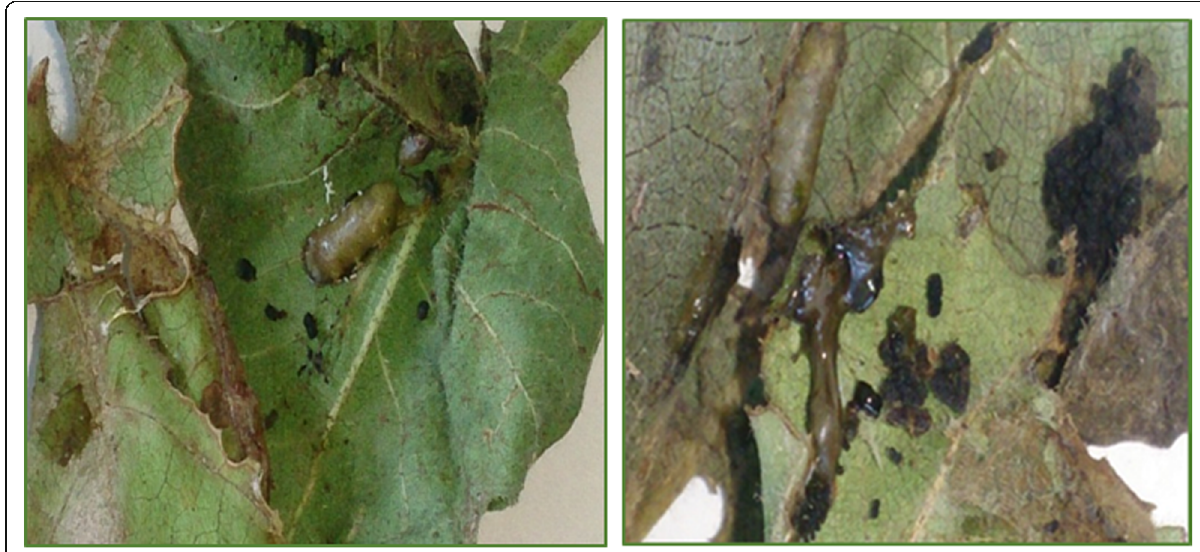
Fig. 4 Effects of B. thuringiensis var. thuringiensis against Syllepte derogate larvae